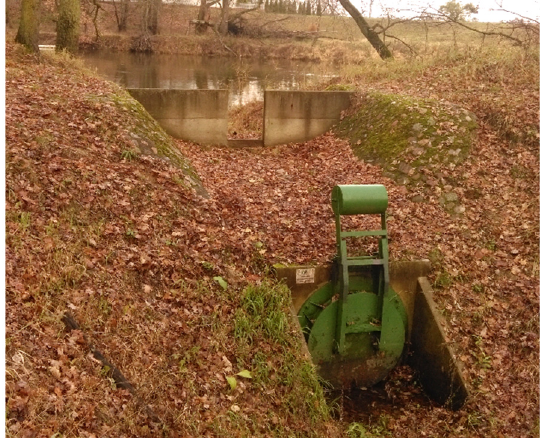
Figure 4. An overspill with a backflow preventer, the “Uroczysko Warta” in the Jarocin Forest District (Photo: A. Krysztofiak-Kaniewska).